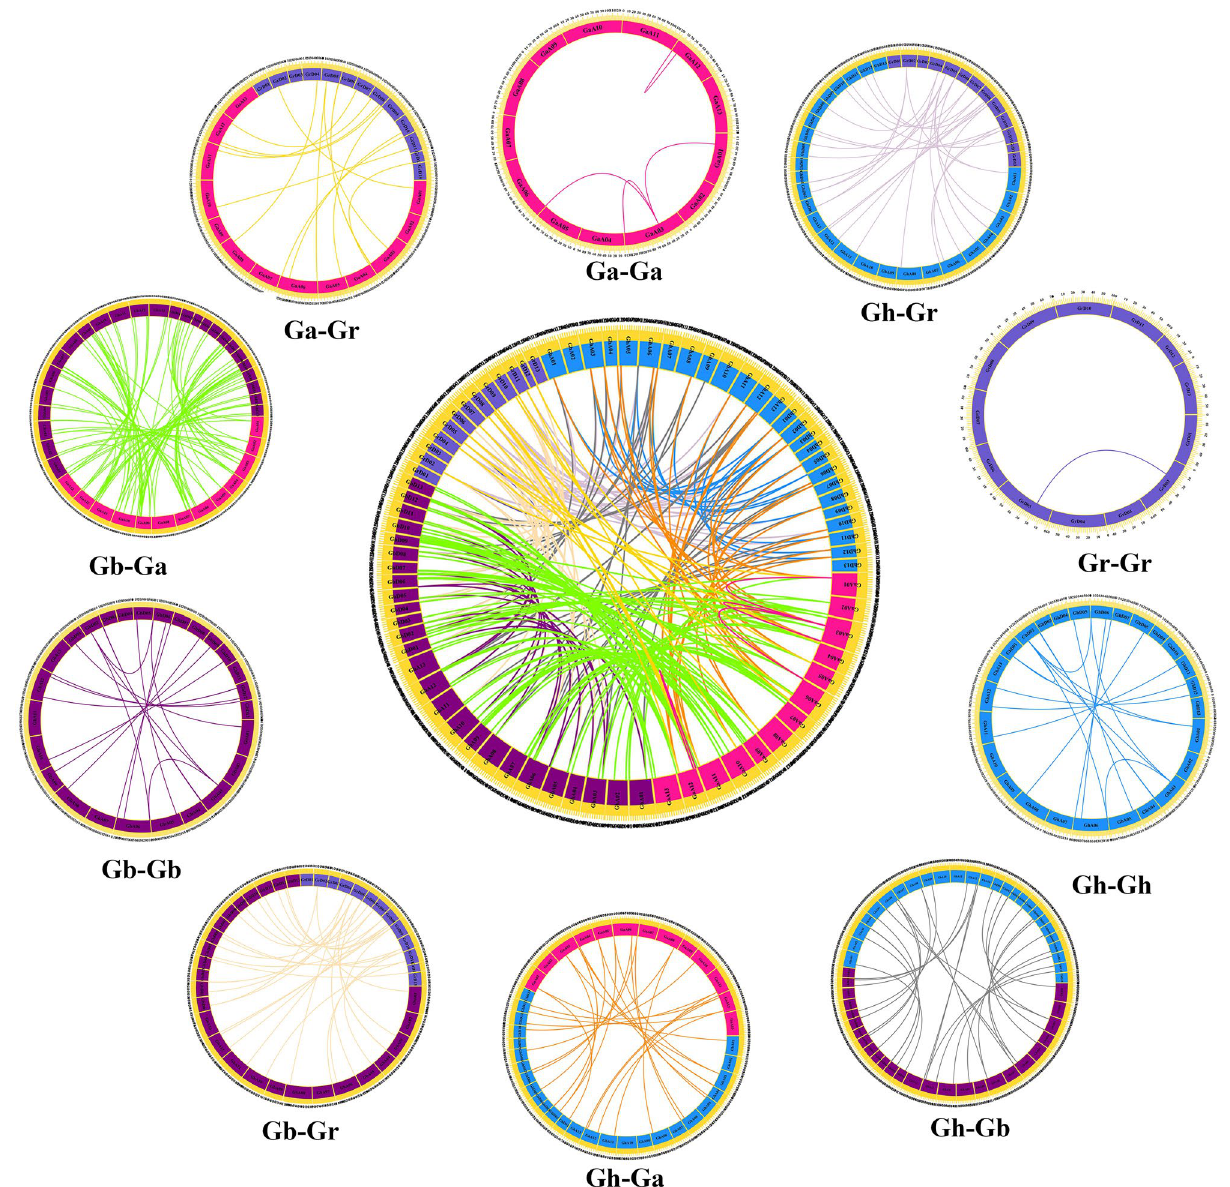
Figure 3. Collinearity analysis of IFR duplicated gene pairs in G. hirsutum , G. barbadense , G. arboretum , and G. raimondii . Chromosomal lines represented by various colors indicate the syntenic regions around the IFR